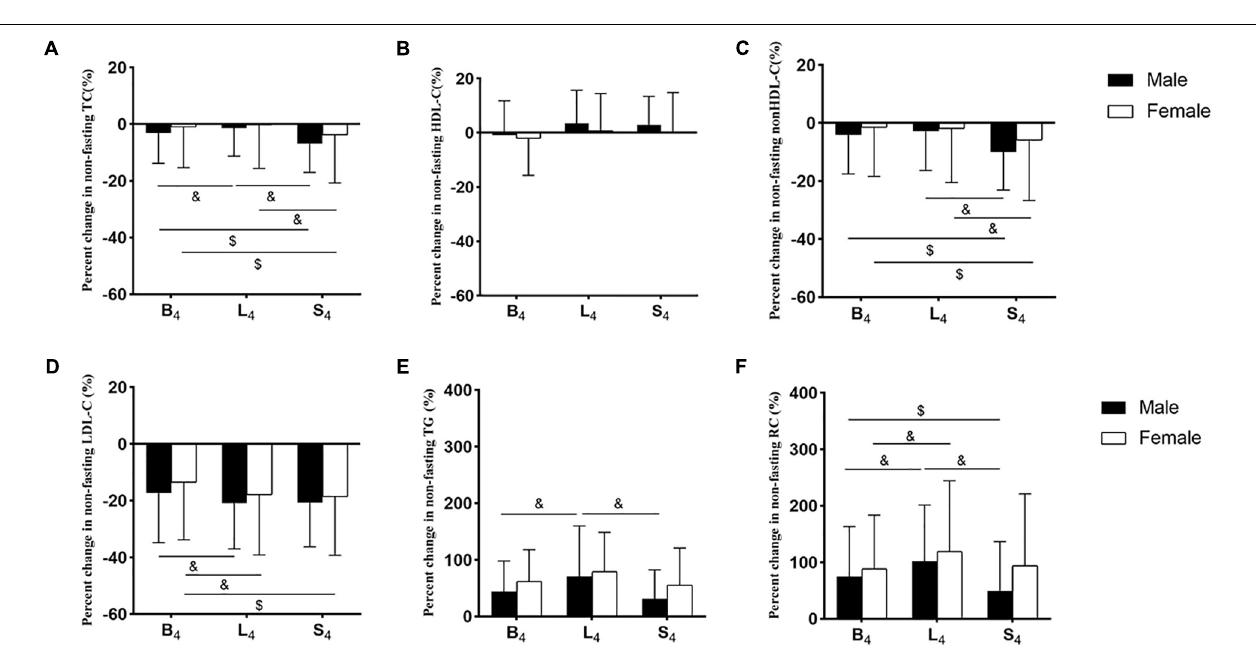
FIGURE 2 | Percent changes in non-fasting blood lipid levels in the two groups. (A–F) Percent changes in non-fasting levels of TC (A) , HDL-C (B) , non-HDL-C (C) , LDL-C (D) , TG (E ), and RC (F) . Levels of non-HDL-C and RC were calculated and estimated, respectively. The percent changes in blood lipid levels were calculated by the formula, that is (each non-fasting level - fasting level) × 100%/fasting level. B 4 : at 4 h after breakfast, L 4 : at 4 h after lunch, S 4 : at 4 h after supper. $ p < 0.05 when compared to the level at 4 h after supper in the same group. & p < 0.05 when compared to the level at 4 h after lunch in the same